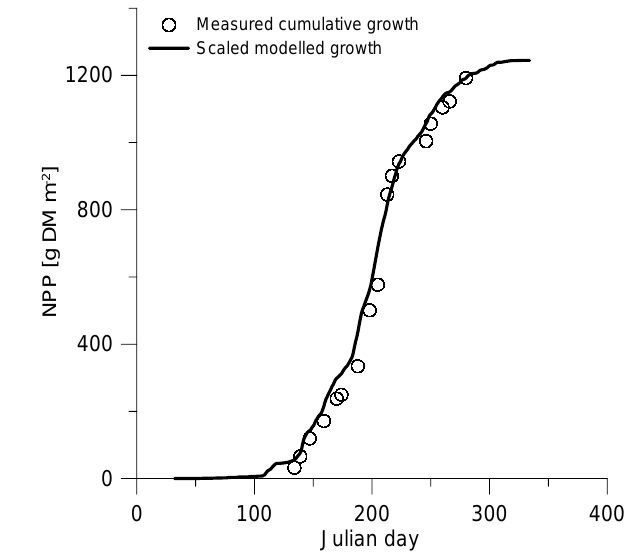
Figure 1. Example of the vegetation model (Eq. 1) fit to a cal- culated cumulative growth curve for a utility lawn in Björkekärr,